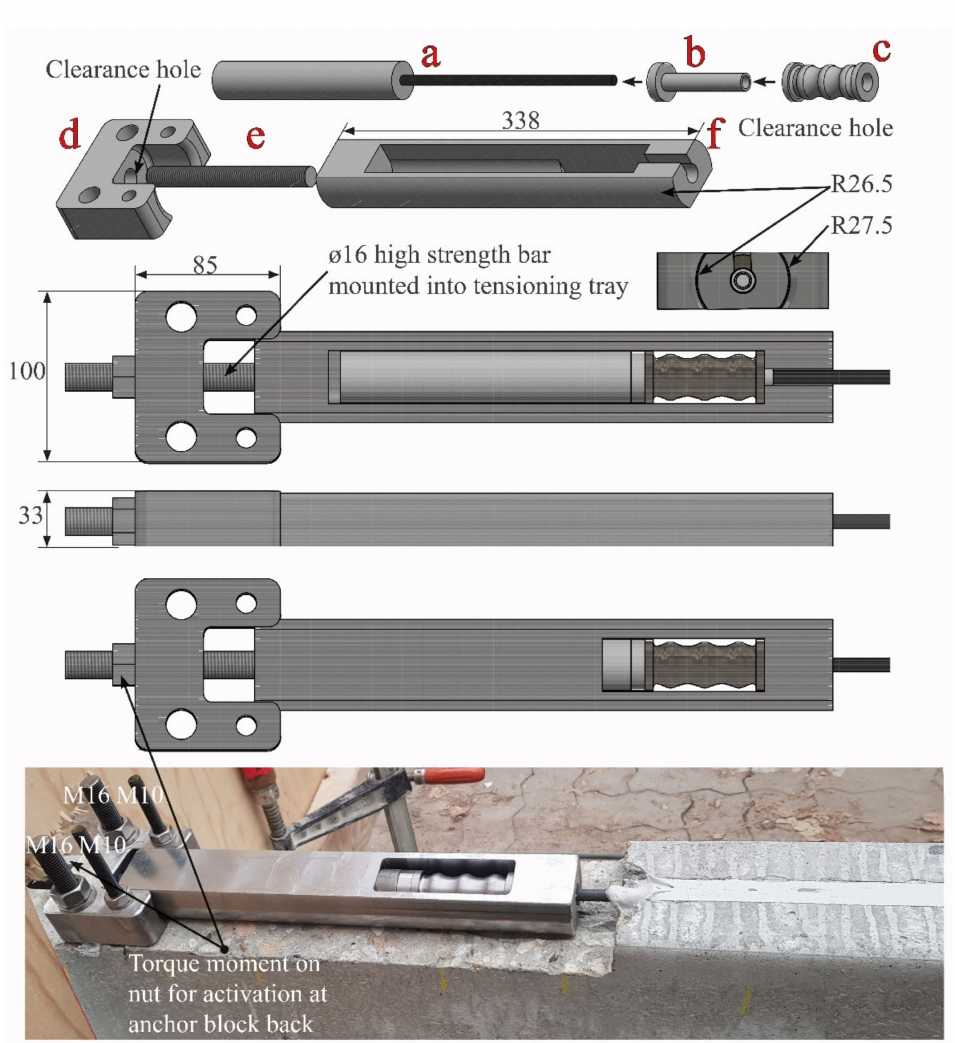
Figure 4. Anchor block used for the ductile Enclosure Wedge (EW) anchor. Note: Units in